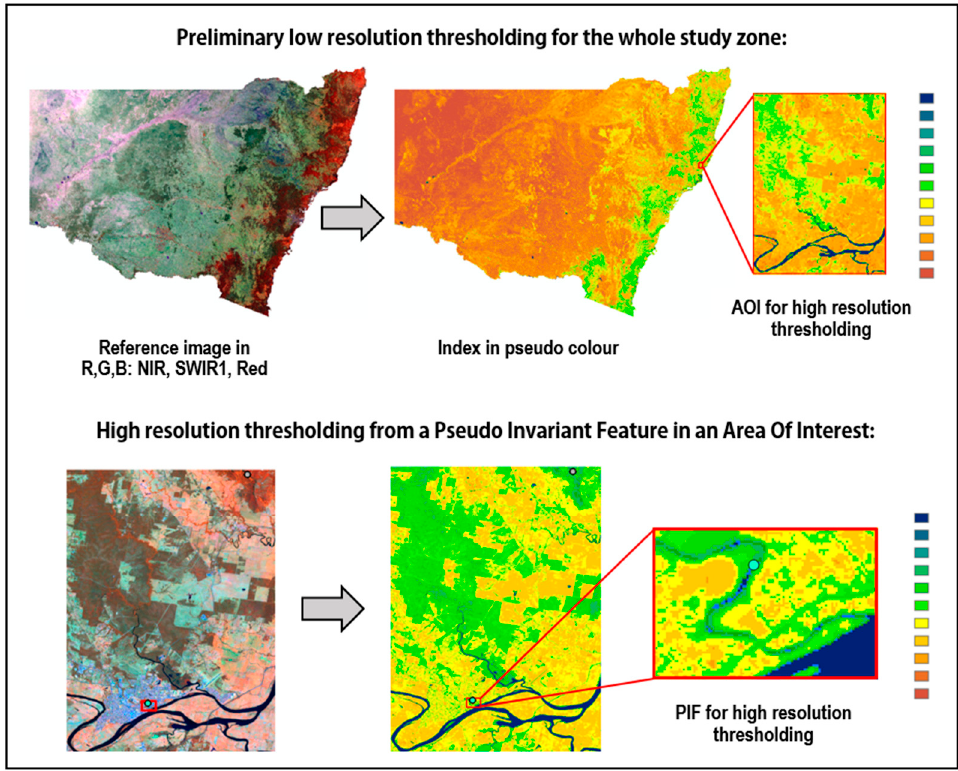
Figure 5. Holistic view of study zone and ‘shuttle analysis’ for index thresholding at low, and then high, resolution. PIF is shown in cyan point. high, resolution. PIF is shown in cyan